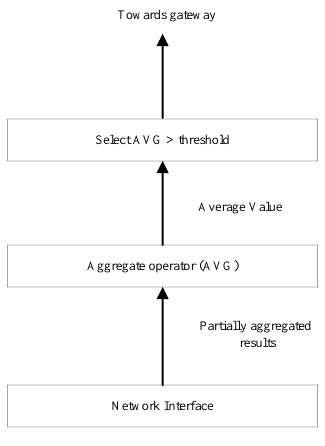
Figure 6. Query plan at a head node: the head node collects all the readings, calculates the